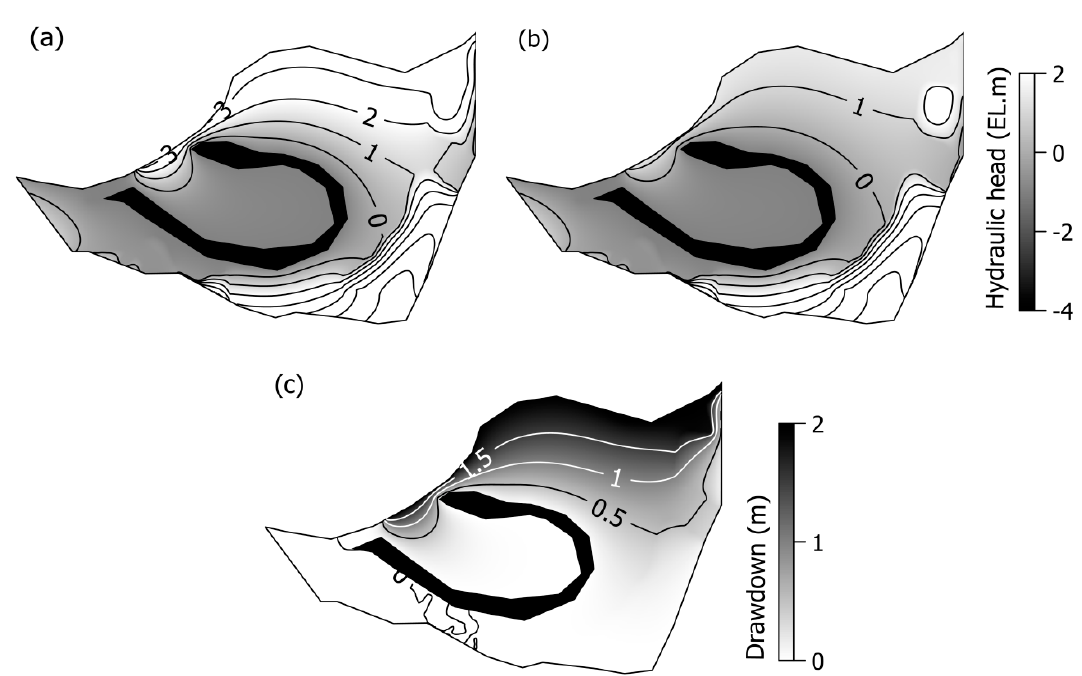
Figure 8. Changes in groundwater level due to water gate operation of Juksan weir ( a ) when the river level was 3.5 m and ( b ) 1.5 m, and ( c ) the drawdown.